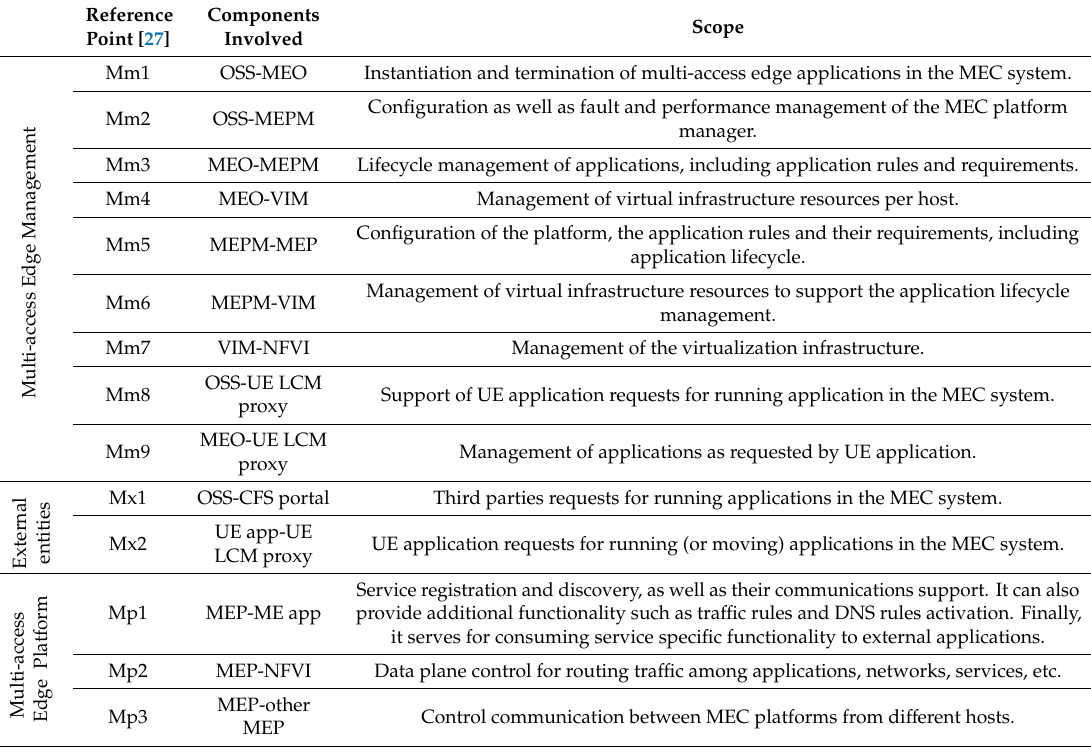
Table 2. Summary of the MEC reference points and their